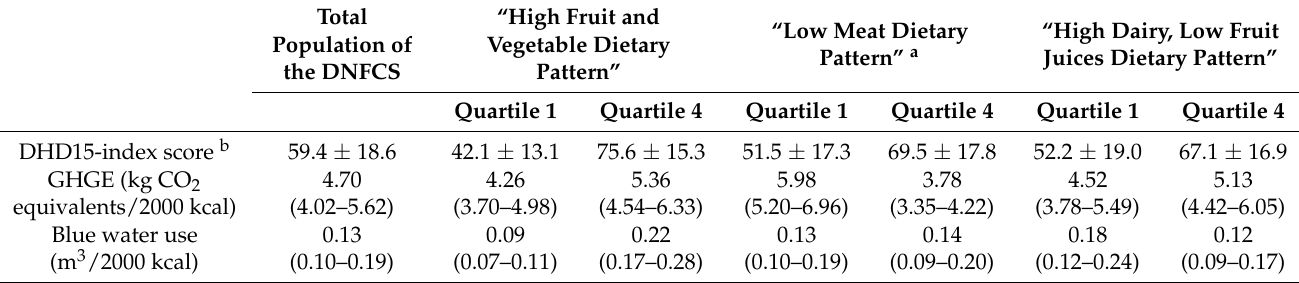
Table 2. Mean ± standard deviation Dutch Healthy diet index 2015 (DHD15-index) score and median (interquartile range) dietary greenhouse gas (GHG) emissions and dietary blue water use of participants in quartile 1 and 4 of the three derived dietary patterns compared to the total adult population of the Dutch National Food Consumption Survey (DNFCS)